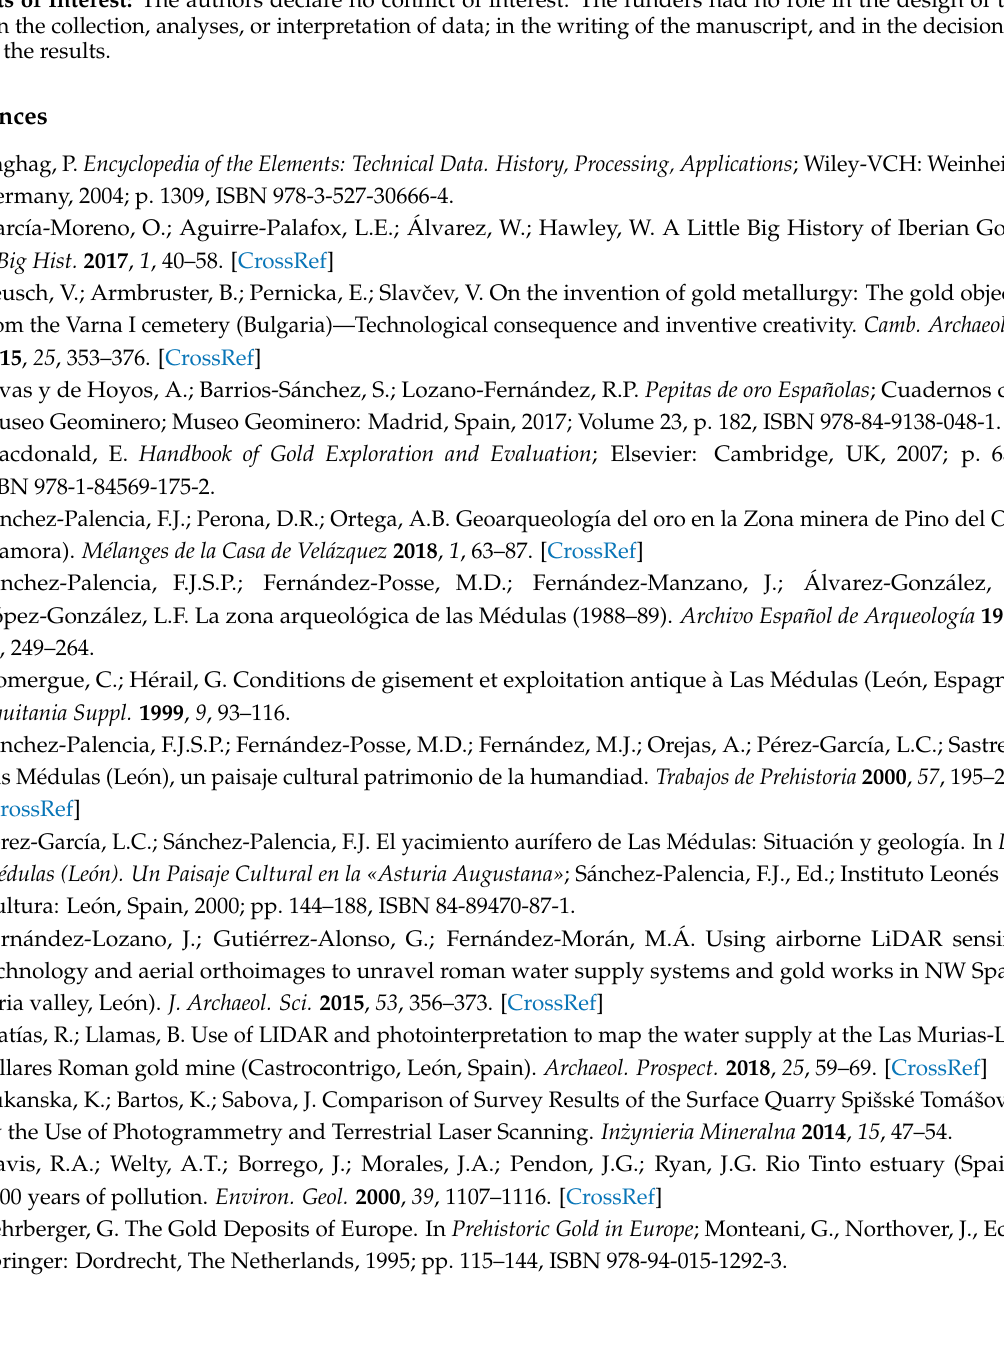
_T8LgRWUk. Figure S1: Roman shallow mine, Figure S2: Deep Roman mine, Figure S3: Murias , Figure S4: Rock tunnel, Figure S5: Water reservoirs, Figure S6: Supply canals, Figure S7: Mining